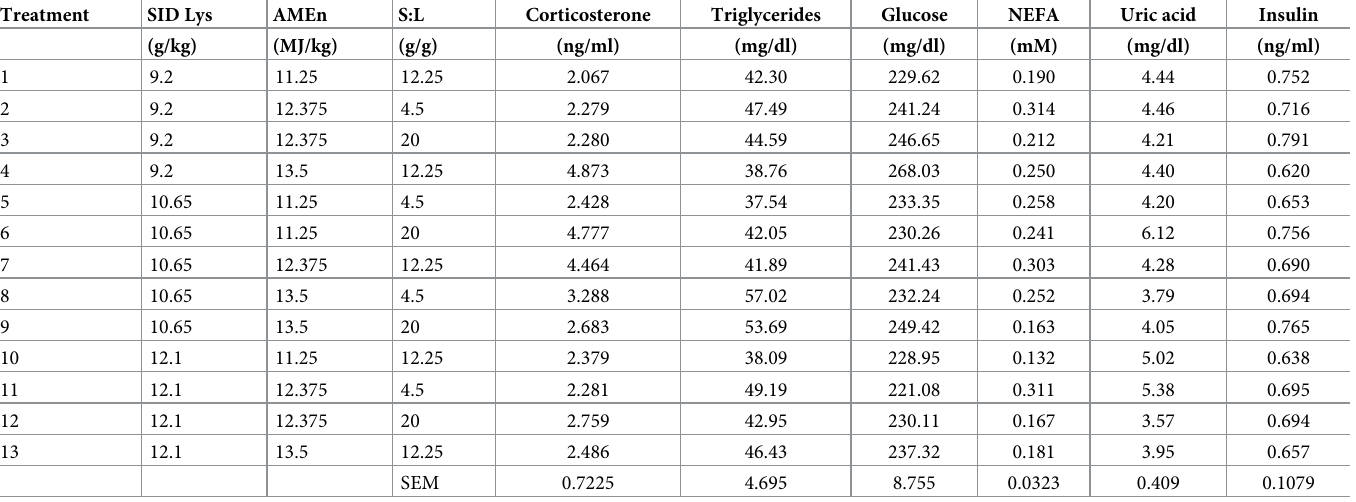
Table 10. Effects of dietary treatment on blood parameters in broiler chickens at 35 days post-hatch. Treatment SID